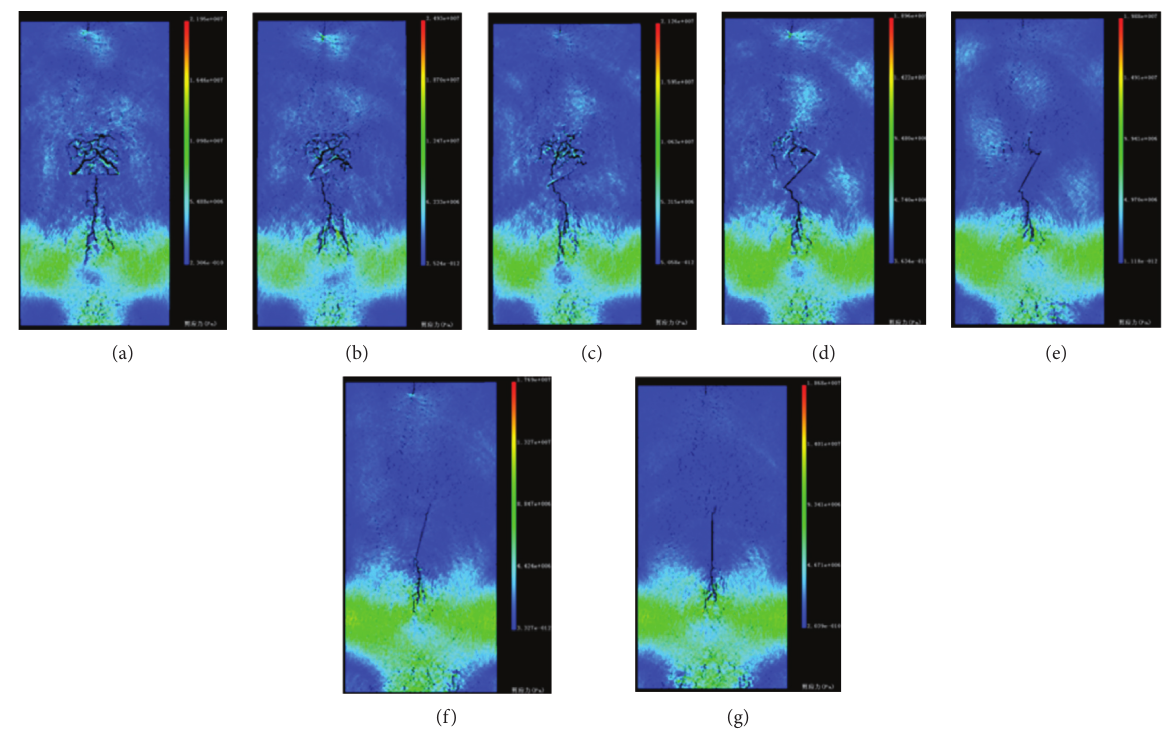
Figure 8: Failure patterns of rock specimens with different inclination angles of preexisting cracks when subjected to stress wave